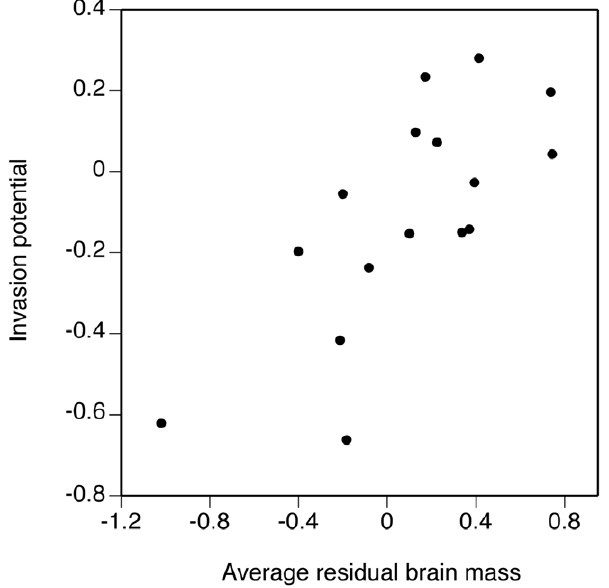
Figure 2. Invasion potential of amphibian and reptile families versus mean residual brain mass of each family. See Methods for calculation of invasion potential.